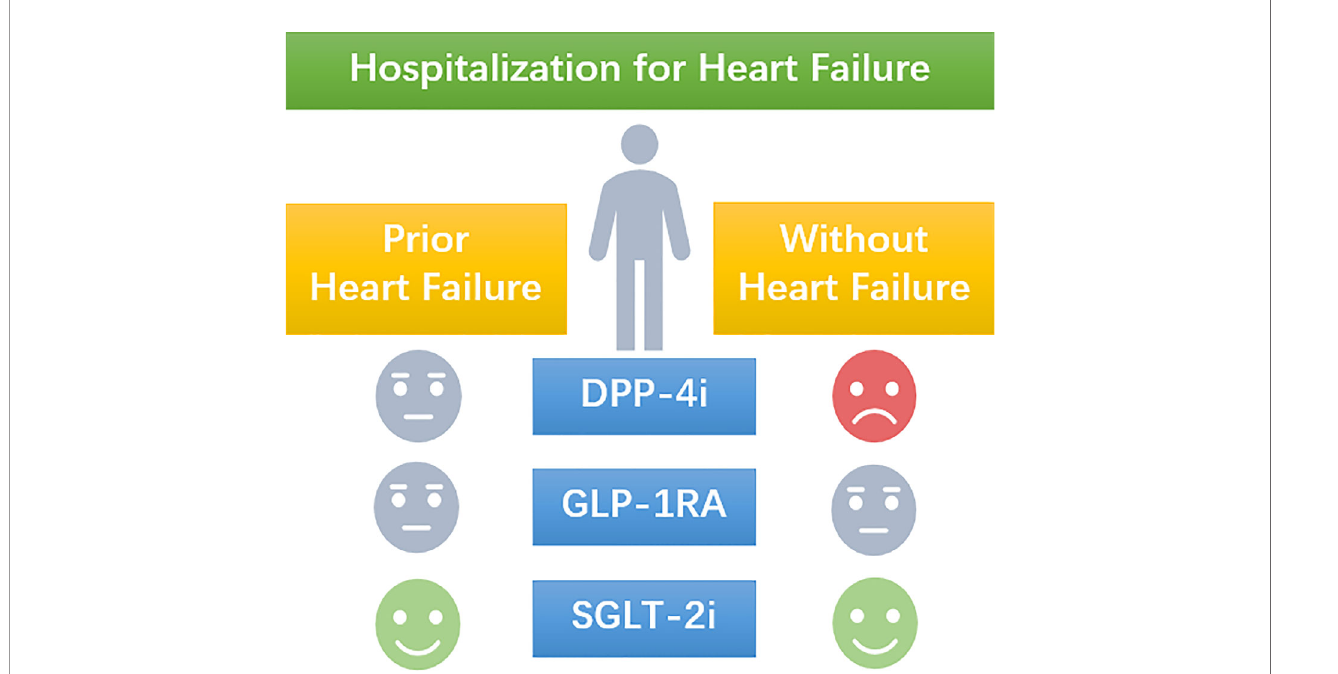
FIGURE 4 | A schematic picture of the manuscript. The use of DPP-4i increases the risk of hospitalization for heart failure in T2D patients without prior heart failure, but present a neutral effect in T2D patients with prior heart failure. The use of GLP-1RA presents a neutral effect on the risk of hospitalization for heart failure no matter the heart failure status of T2D patients. SGLT-2i reduces the risk of hospitalization for heart failure no matter the heart failure status of T2D